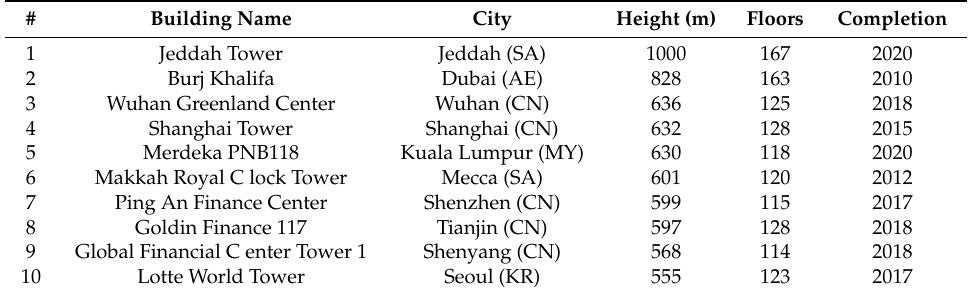
Table 2. The world’s 10 tallest skyscrapers in 2020. Note that all these buildings will be in Asia and the Middle East—North America will have none.